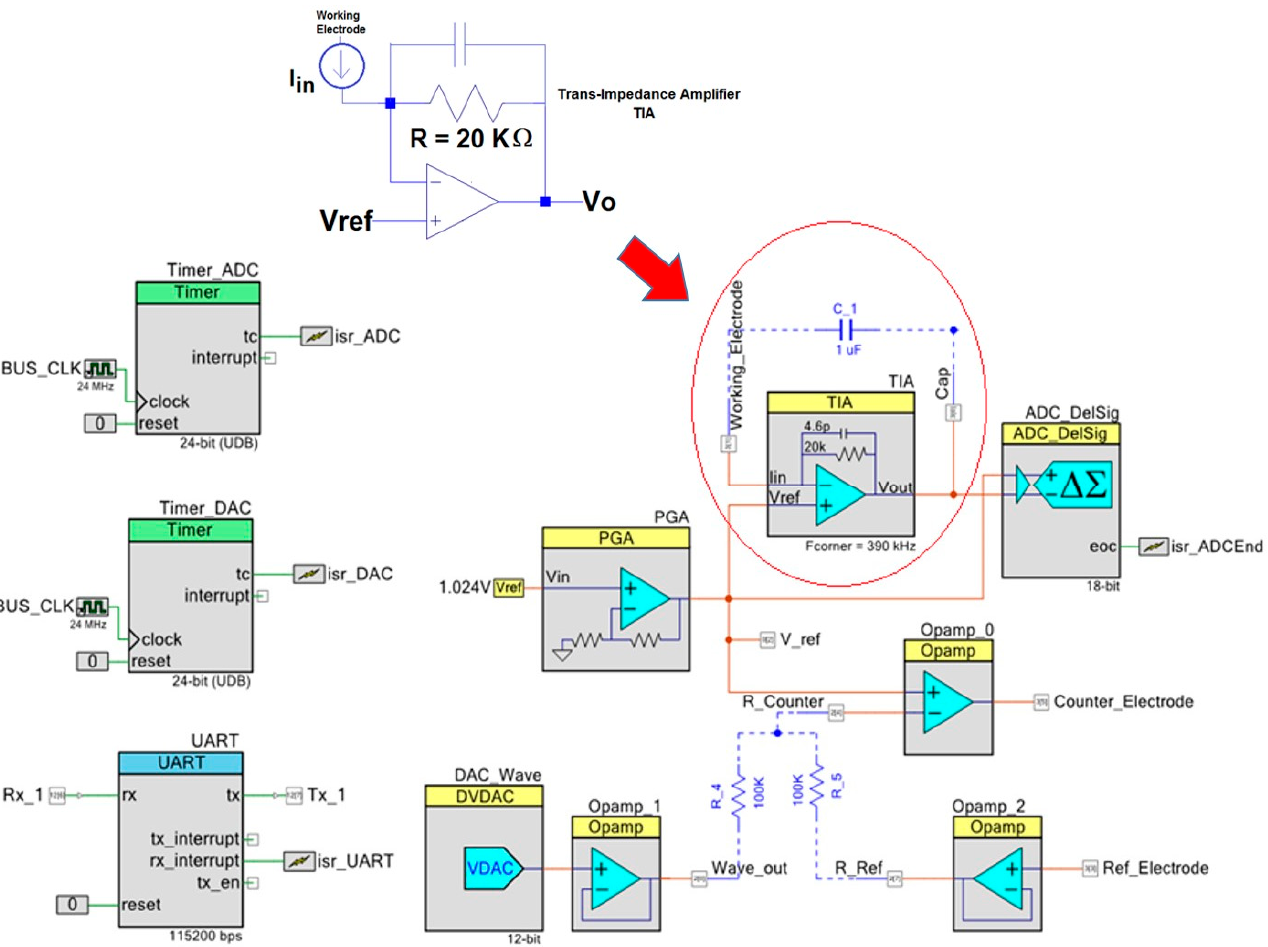
Figure 4. Digital peripherals and analog front end devices of the PSoC. Digital to Analog Converter (DAC), Analog to Digital converter (ADC), Input-Output Port (UART), Trans-Impedance Amplifier (TIA).